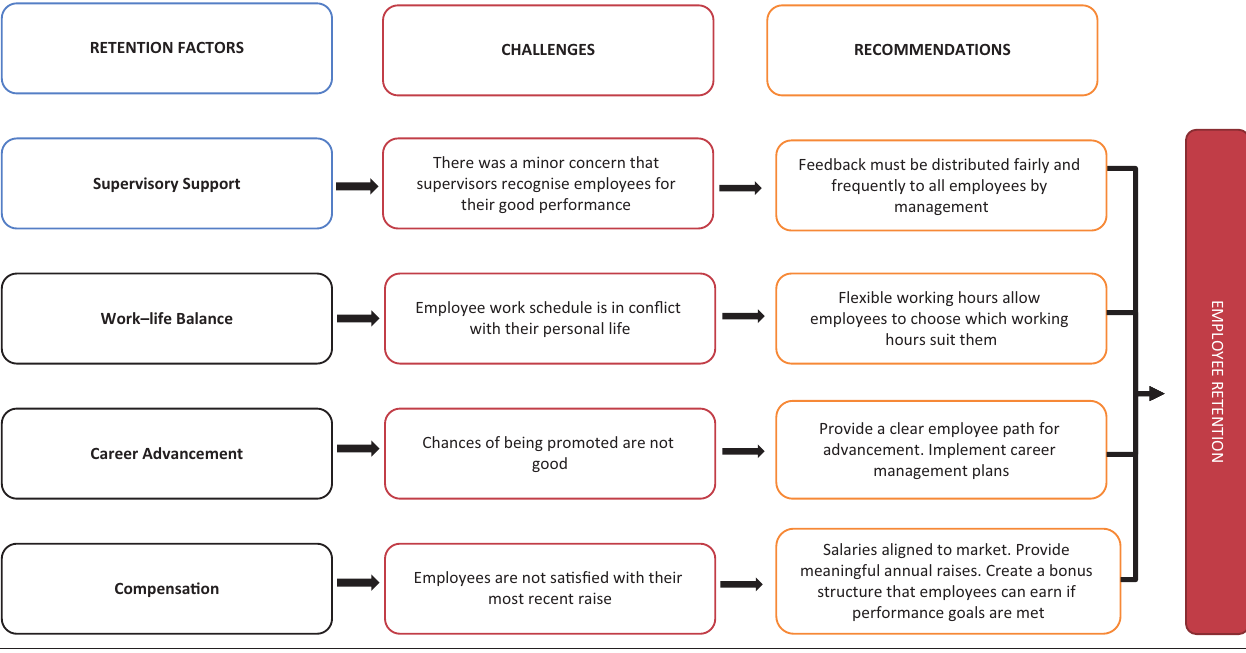
FIGURE 1: Recommendations on how to enhance employee